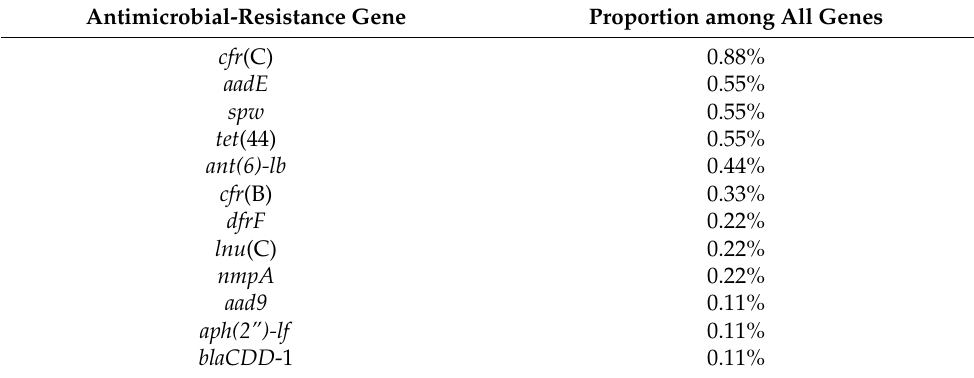
Table 2. Cont. Antimicrobial-Resistance Gene